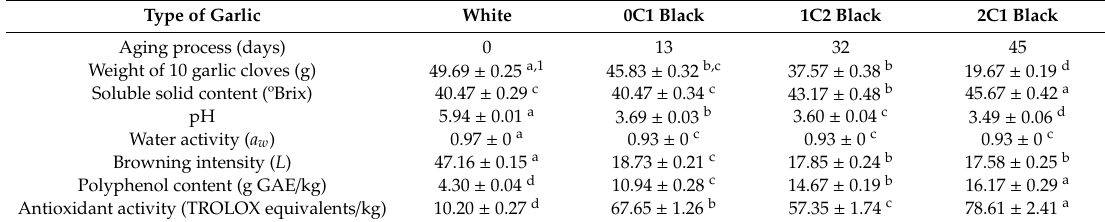
Table 1. Physicochemical characterization of four types of garlic according to the days of